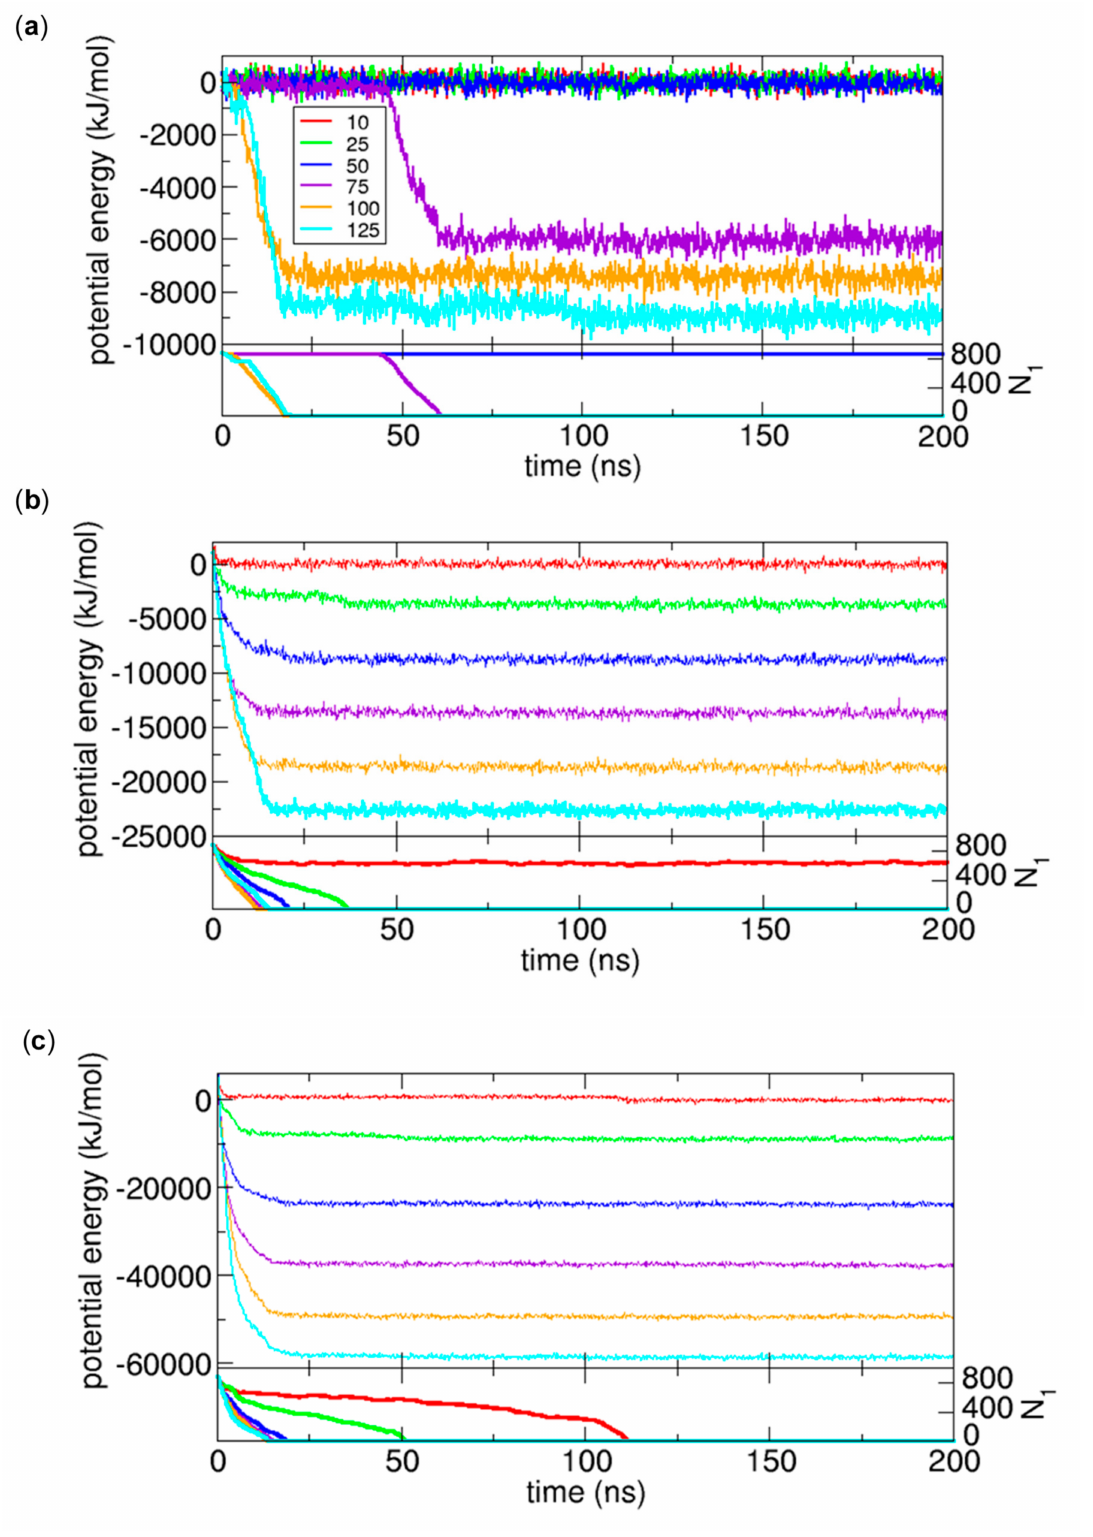
Figure 6. Changes in potential energy and in the number of water molecules in Compartment 1 ( N 1 ) as functions of time for the cases of N O = 10, 25, 50, 75, 100, and 125 when ( a ) IS WO = 10 ( b ) IS WO = 20, and ( c ) IS WO =